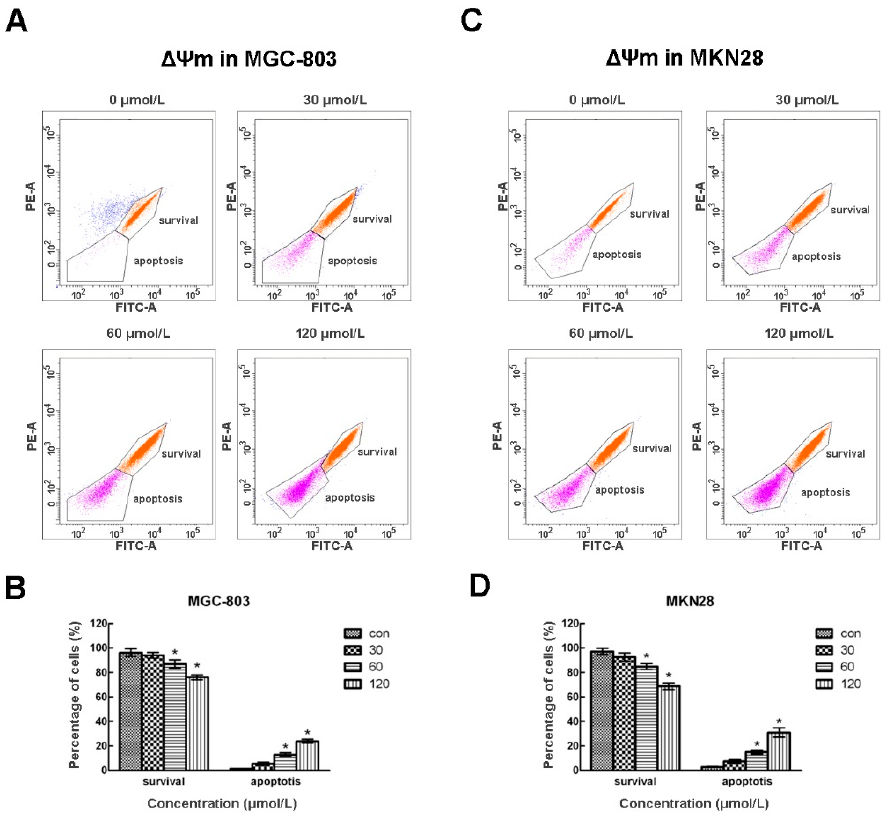
Figure 4. CVB-D results in loss of ΔΨ m in MGC-803 and MKN28 cells. ( A , C ) Representative flow cytometry graphs of ΔΨ m of CVB-D (0, 30, 60 and 120 µmol/L) treated MGC-803 ( A ); and MKN28 cells ( C ); ( B , D ) Statistic analysis of cells numbers at different populations of CVB-D treated MGC-803 ( B ); and MKN28 cells ( D ). Rh123 + , Survival cells; Rh123 − , apoptotic cells. * p < 0.05. Each experiment involved at least three replicates.